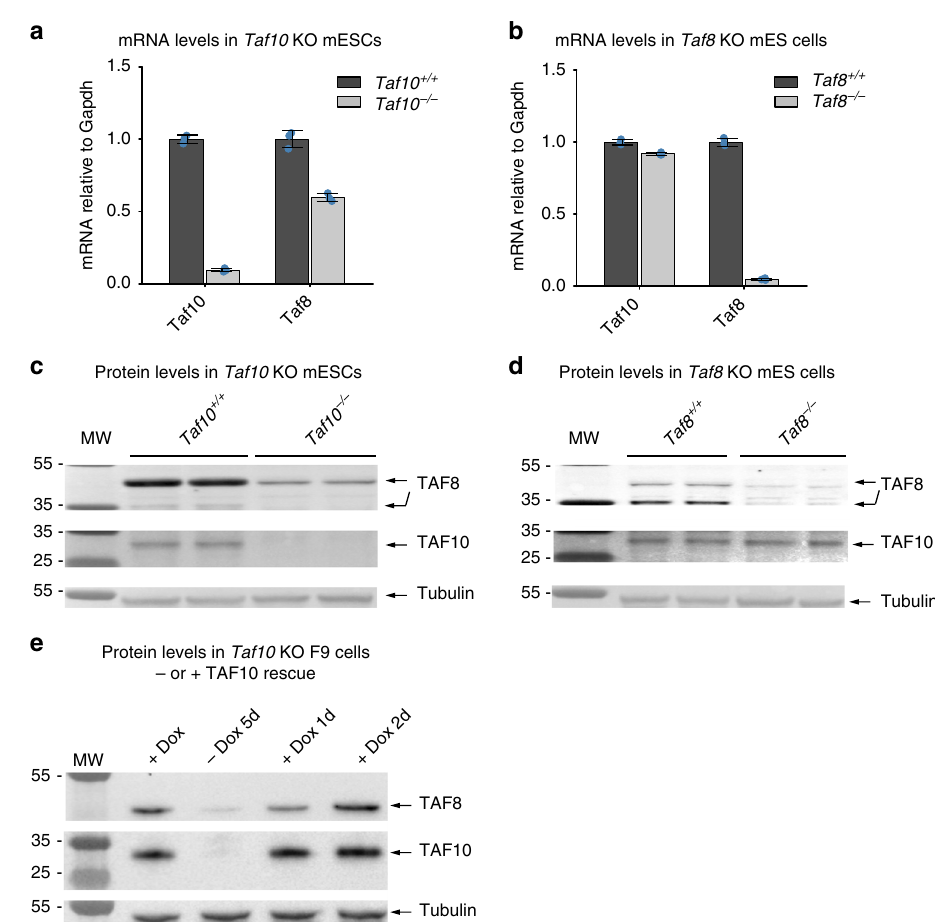
Fig. 4 TAF10 depletion causes degradation of TAF8 in KO mESCs. a , b RT-qPCR of TAF10 ( a ) and TAF8 ( b ) depleted mESCs. c , d Western blot analyses from TAF10 ( c ) and TAF8 ( d ) depleted mESCs whole-cell extract using anti-TAF8 and anti-TAF10 antibodies. e Western blot analysis of whole cell extracts prepared from the mouse Taf10 − / − F9 cells with or without Doxycycline (Dox) for the indicated number of days ( d ) using anti-TAF8 and anti-TAF10 antibodies. In panels ( a , b ), mRNA levels were normalised to Gapdh mRNA and relative enrichment was calculated using the ΔΔ Cp method and error bars represent ±SD from three technical replicates (represented by blue dots). In panels ( c – e ), molecular weight (MW) markers are shown in kDa and an anti- Tubulin was used as a loading control. In panels ( c – d ), the two protein isoforms of mTAF8 are indicated. Source data provided as a Source Data